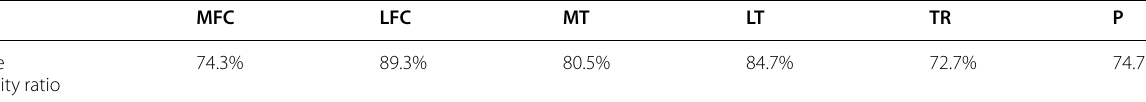
MFC Medial femoral condyle LFC Lateral femoral condyle MT Medial tibial